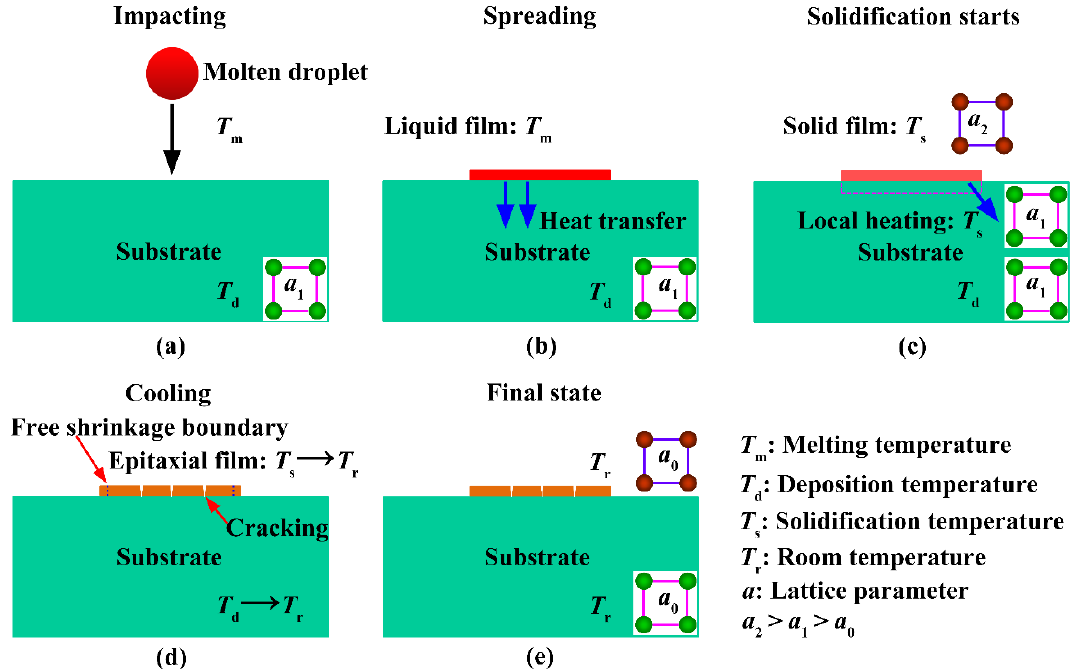
Fig. 22 Detailed film formation process during the present liquid homoepitaxy by thermal spray technology. (a) Molten droplet with high-speed impacts on single-crystal substrate surface, (b) droplet quickly spreads on the substrate forming a liquid film, (c) liquid film starts solidification on substrate forming a solid epitaxial film, (d) during the subsequent cooling, the epitaxial film would shrink with the temperature from T s to T r , and (e) epitaxial film/substrate system was formed at room temperature. The blue dashed lines in the epitaxial film in (d) denote the position in the case of free shrinkage. Reproduced with permission from Ref. [126], © ASM International